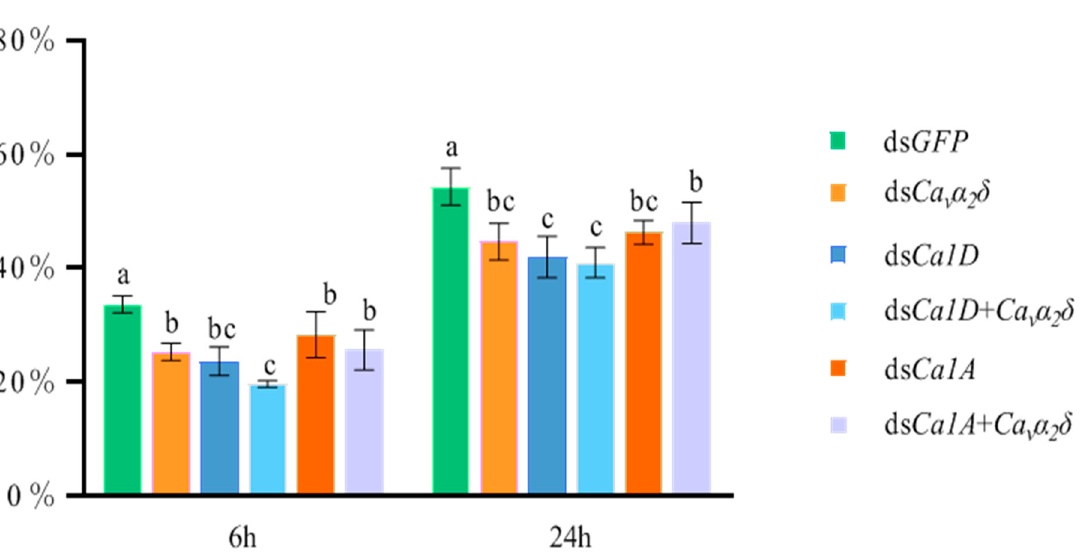
Figure 8. Effect of dsRNA soaking on the motility of D. destructor . One hundred J2-J3 worms treated with dsRNA were added to the sand column, and the number of worms passing through the sand column was counted at 6 h and 24 h, respectively, to calculate the migration rating. Each column represents the mean ± standard error of three replicates. Different letters indicate significant differences at p < 0.05 by Duncan’s multiple range test. The experiments were performed three times with similar results.